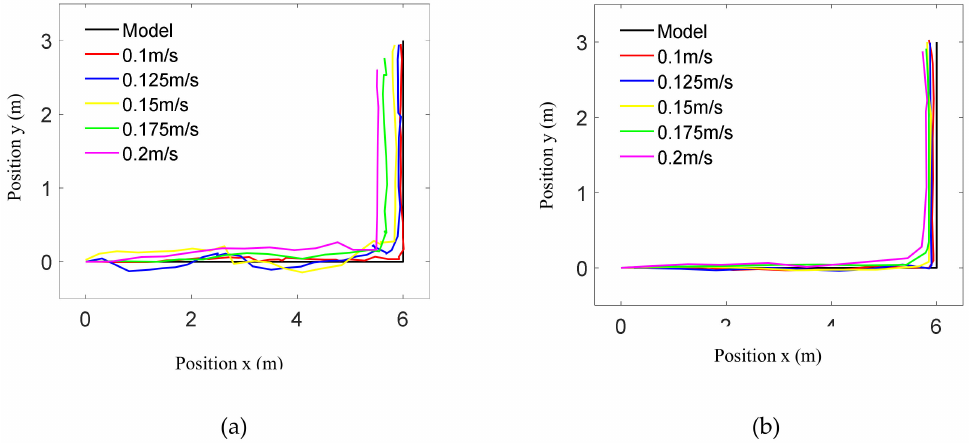
Figure 11. Localization results using ICP ( a ) and our FFT-ICP2 method ( b ) under different speeds.